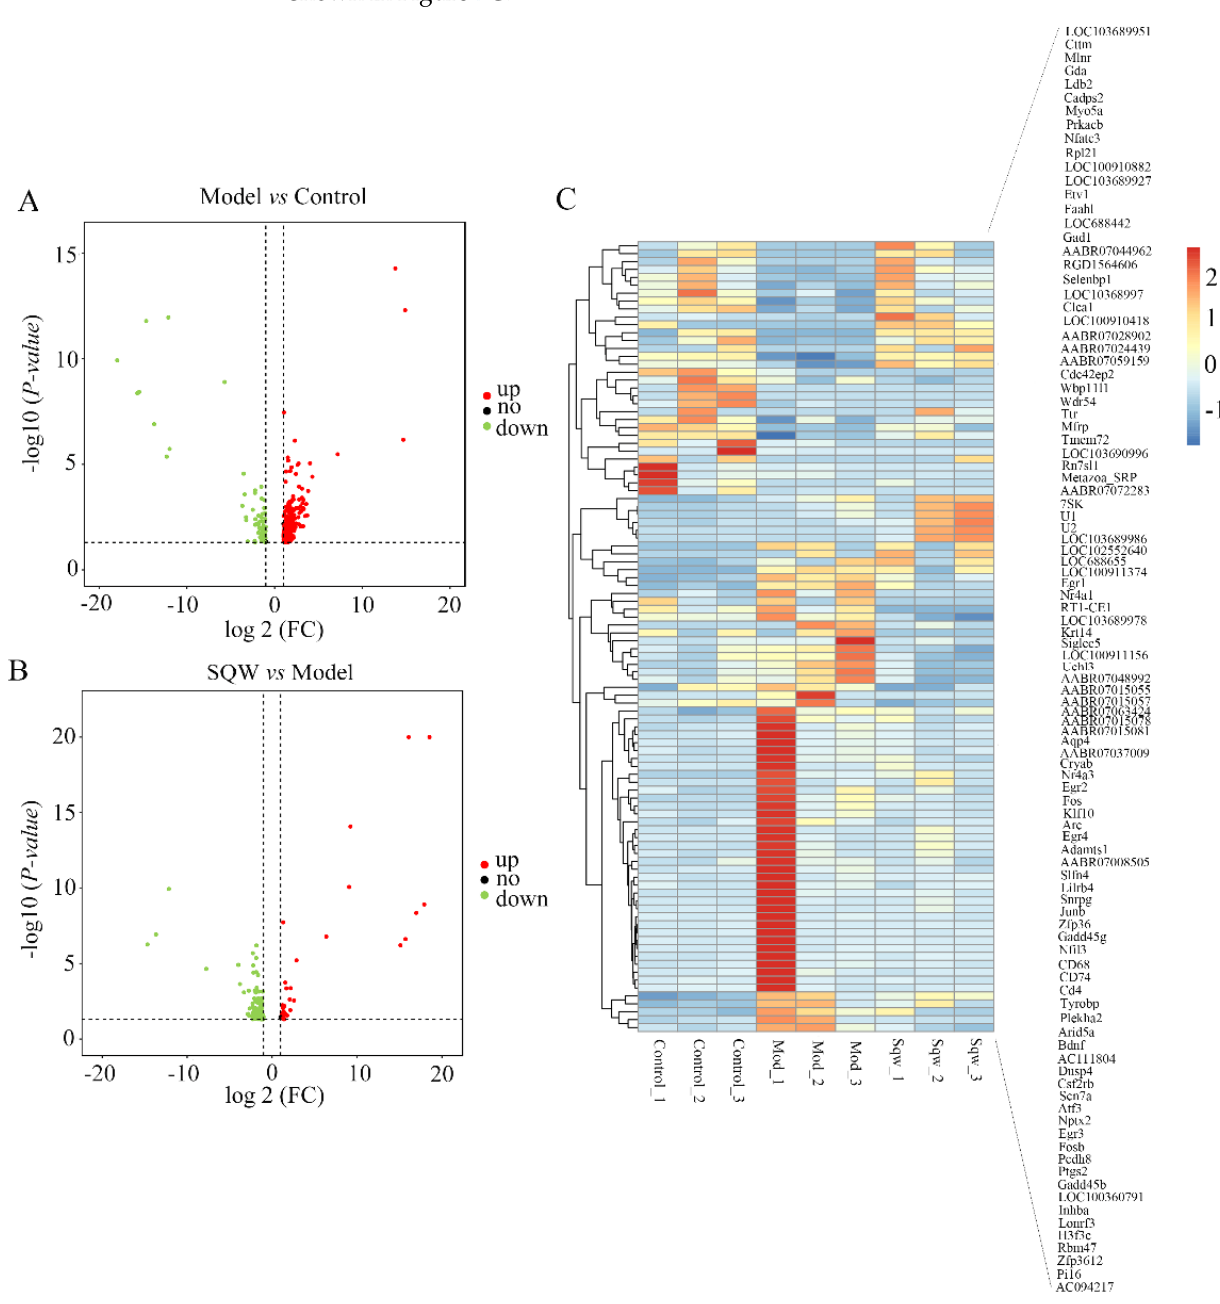
Figure 6. Identification of De mRNAs in AD rats with SQW treatment. ( A ) Volcano plot for De mRNAs between STZ induced group and control group. ( B ) Volcano plot for De mRNAs between SQW group and model group. The horizontal axis is logFold Change (FC), and the vertical axis is the p -value after the negative logarithm conversion. Up- and down-regulated genes are marked in red and blue, respectively. ( C ) Heat map of the top 100 differentially expressed genes. Red indicates high expression levels and green low expression levels.